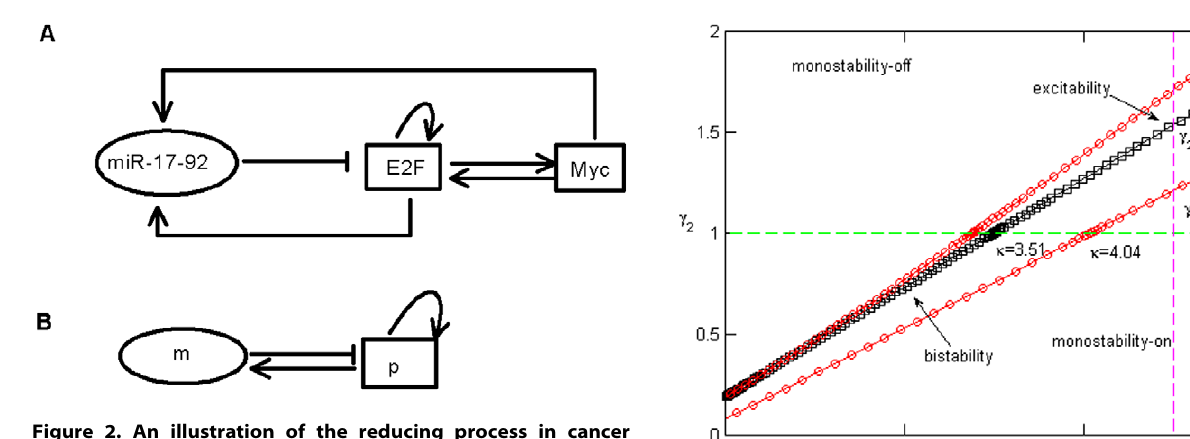
Figure 2. An illustration of the reducing process in cancer networks involving miR-17-92, E2F, and Myc. (A) Model of the interaction between E2F, Myc and miR-17-92. (B) The final reduced abstract model. Variables p and m represent the protein module (Myc and E2Fs) and the miR-17-92 gene cluster, respectively.